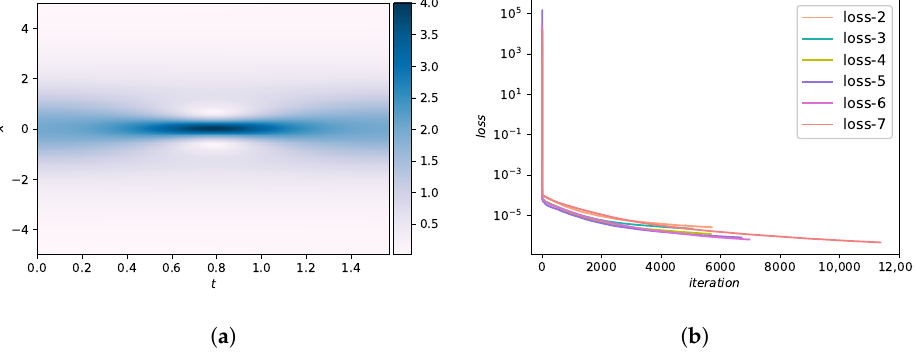
Figure 5. Results of Equation (22). ( a ) The predicted solution | h ( t , x ) | . ( b ) The change process of the objective function versus iteration